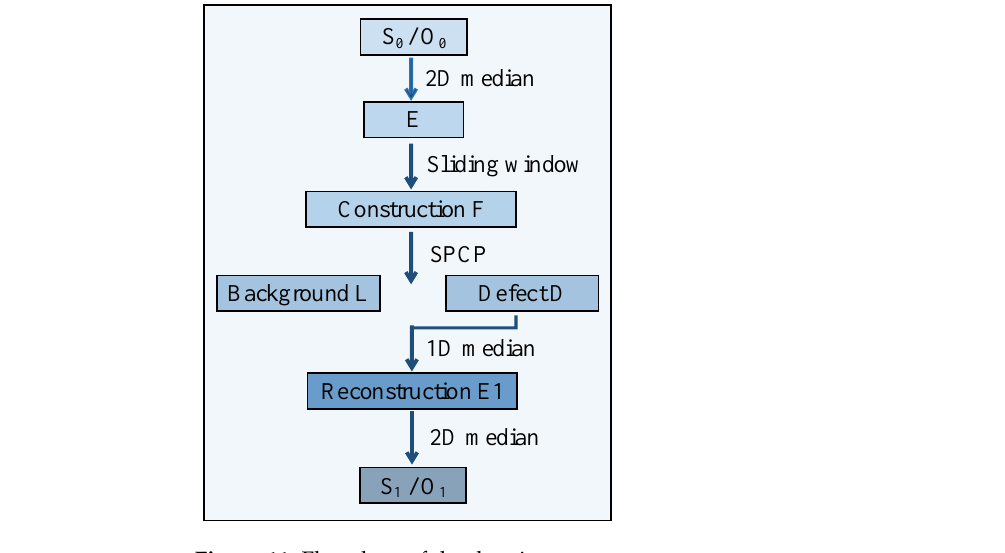
Figure 11. Flowchart of the denoise.